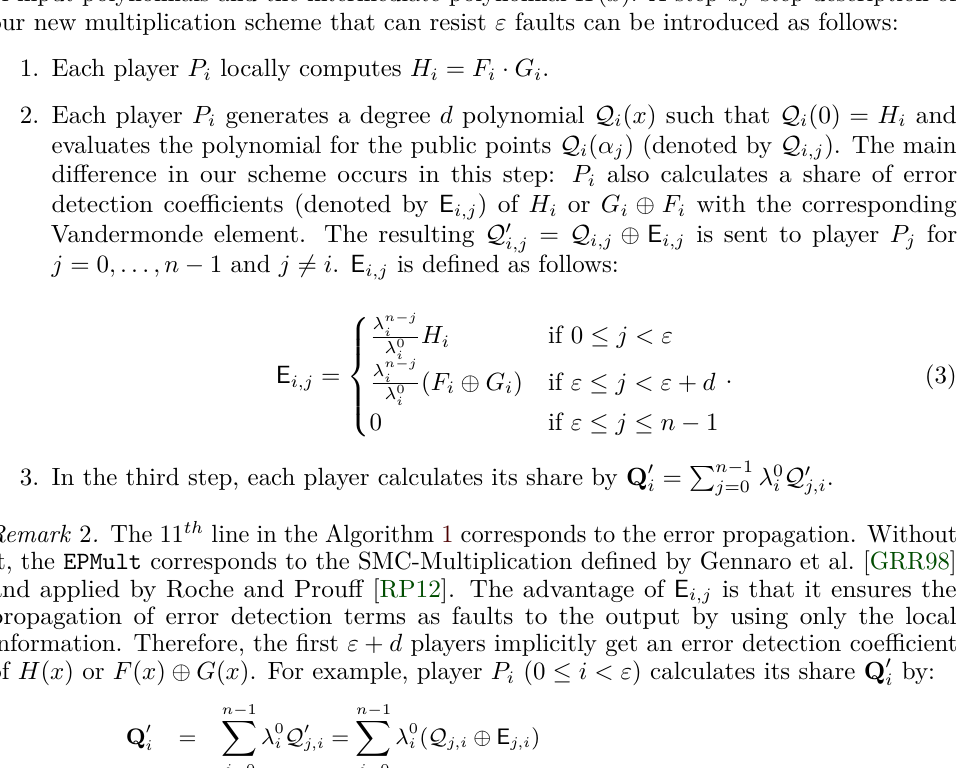
Figure 1: Detailed visualization of (4,1)-SMC Multiplication. Dashed lines show the communications between players ( P i ). The shares of error detection terms of H ( x ) , F ( x ) , and G ( x ) are forwarded to shares of f 0 g 0 during the randomization step. Thus, each Q 0 contains a share of error detection terms of F ( x ) , G ( x ) , or H ( x ) . that to detect ε errors, a total of n > 2 d + ε shares are needed. A representation of the (4,1)-error preserving multiplication can be seen in Figure